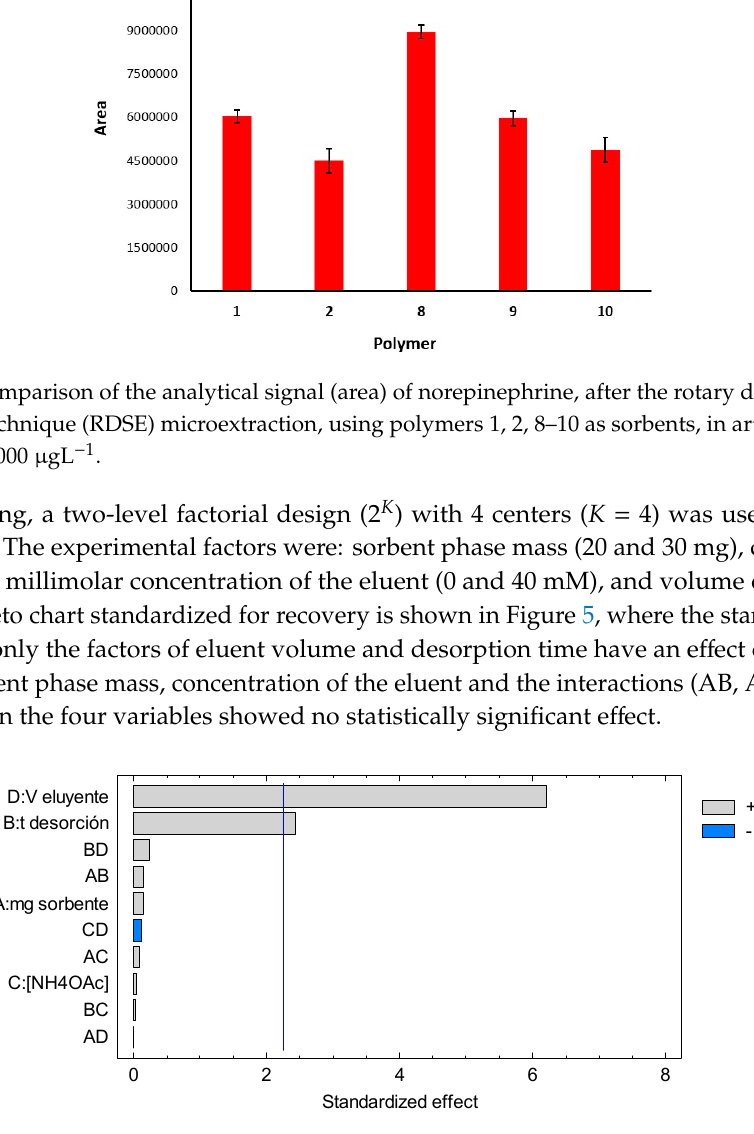
Figure 5. Standardized Pareto chart of the experimental design of the screening.